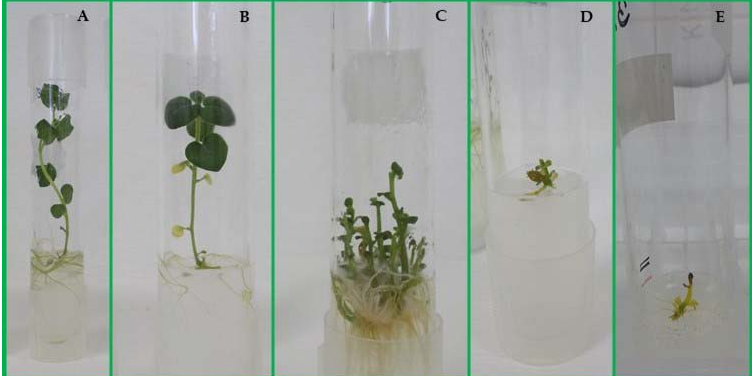
Figure 1. Effect of antiviral drugs on the growth and development of potato ( Solanum tuberosum L.) in vitro shoots. Control plantlets on medium without antiviral drug ( A ); yellowing bottom leaves on plantlets grown on medium with ribavirin (25 mg/L) ( B ); enhanced shoot proliferation of explants (V-4 clone) grown on medium with 30 mg/L RBV + 20 mg/L ZDV ( C ); microtuber development on nodal explants of V-2 clone cultured on medium with 30 mg/L RBV + 20 mg/L ZDV ( D ); shoot tip necrosis on plantlets of 014PS clone grown on medium with 25 mg/L Adefovir ( E ). Photographs were taken by authors in Nyíregyháza (Hungary)